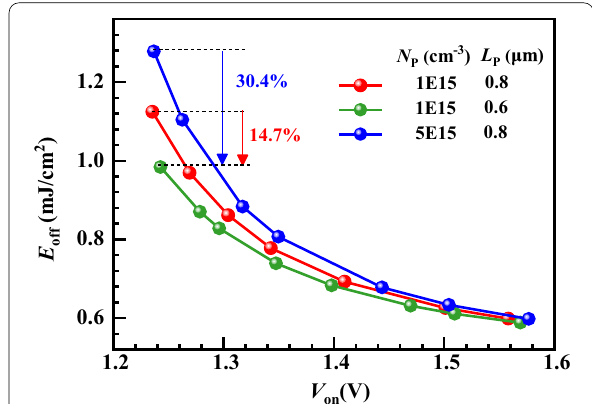
Fig. 9 E off versus V on for the ISM RC-LIGBT with different N P and L P at J